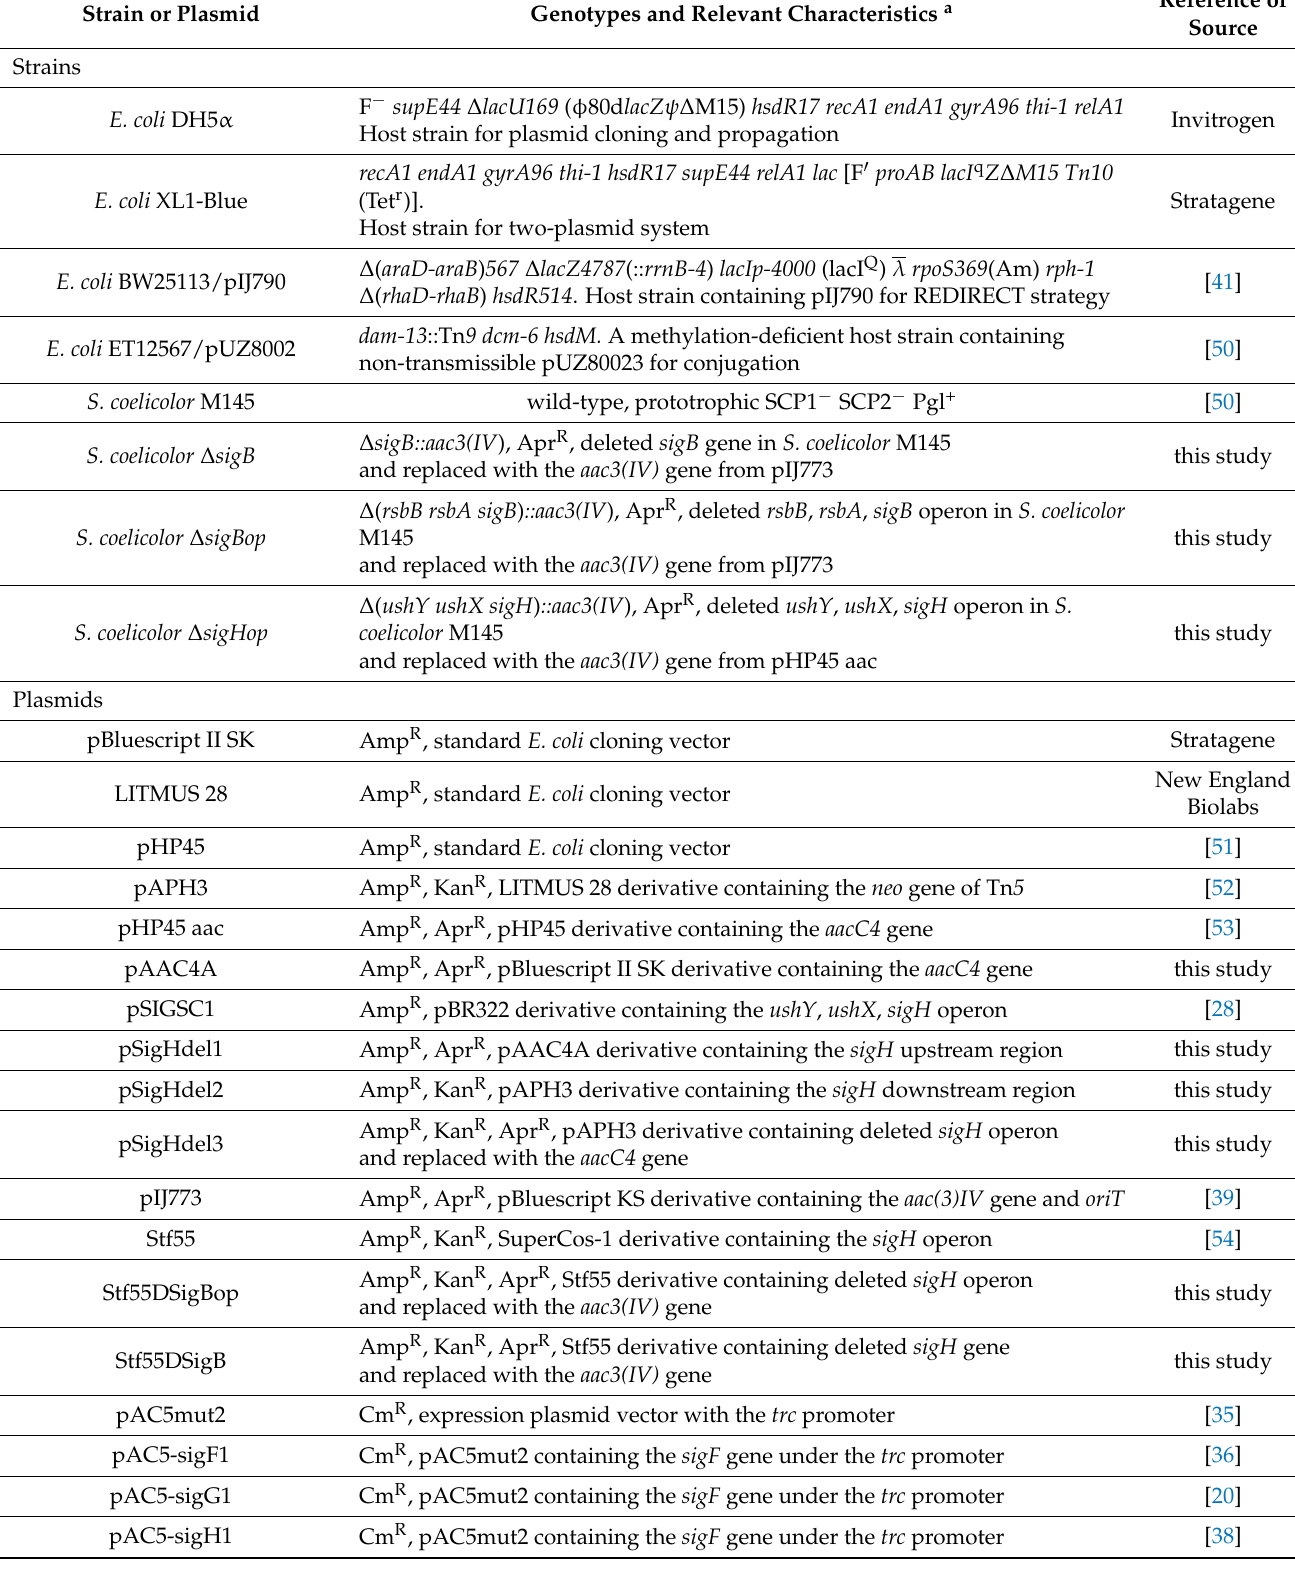
Table 3. Bacterial strains and plasmids used in this